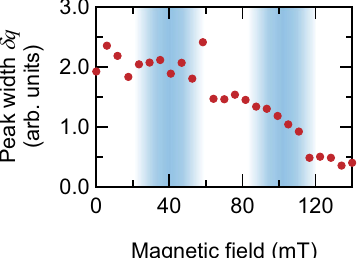
Fig. 5 Magnon peak width extracted from simulated spectral functions. A Gaussian fi t of magnon peaks is performed on the cuts of the magnon spectral function S( q , ω = 8 meV) and the magnon peak width δ q is determined. Plotted is the magnetic fi eld dependence. The blue-shaded areas are guides to the eye indicating the magnetic phase